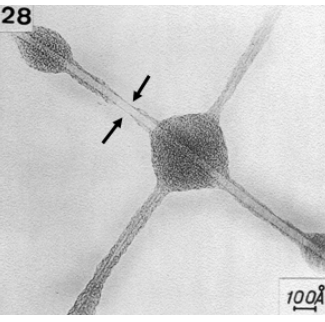
Figure 2. Carbon nanotube-like structures. Adapted from reference [8] with permission